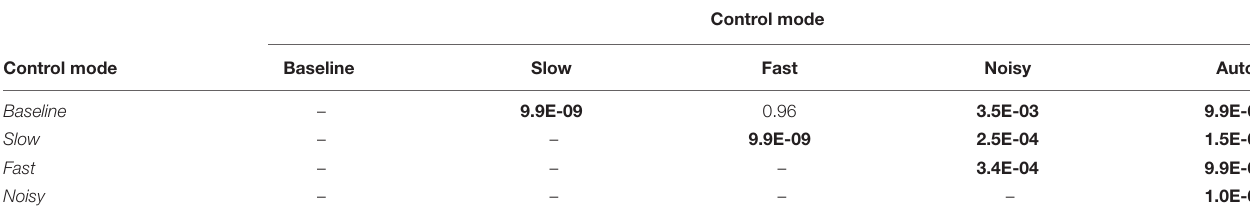
TABLE 3D | Post hoc comparisons ( p -value) between control modes for correction efficiency (smoothness over acceleration).